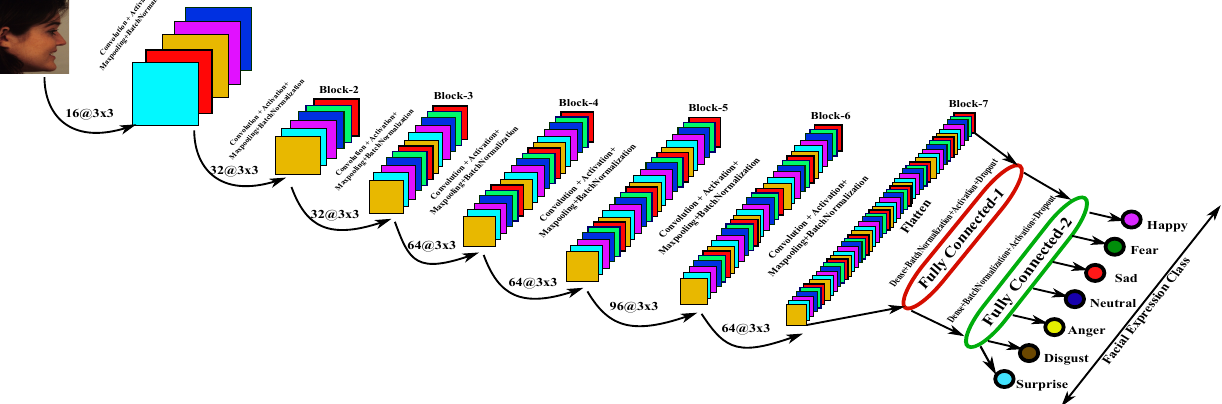
Figure 6. CNN 3 architecture for the proposed FER system, that takes the input image F of size ( n 3 × n 3 × 3 )